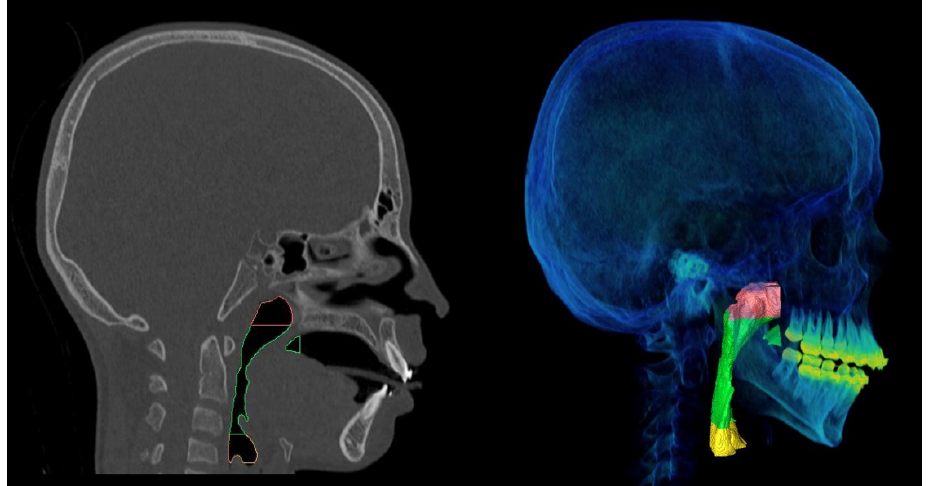
Figure 1. Pharyngeal airway space sub-regions division with posterior nasal spine (PNS) as the anterior vertical limit and pharyngeal soft tissue contour as the posterior limit. Red color indicates nasopharyngeal region extending from root of clivus superiorly to PNS inferiorly. Green color indicates oropharyngeal area extending from PNS superiorly to anterior–inferior point of the body of third cervical vertebrae (C3ai) inferiorly. Yellow color indicates hypopharyngeal region extending from C3ai superiorly to anterior–inferior point of the body of fourth cervical vertebrae inferiorly (C4ai).